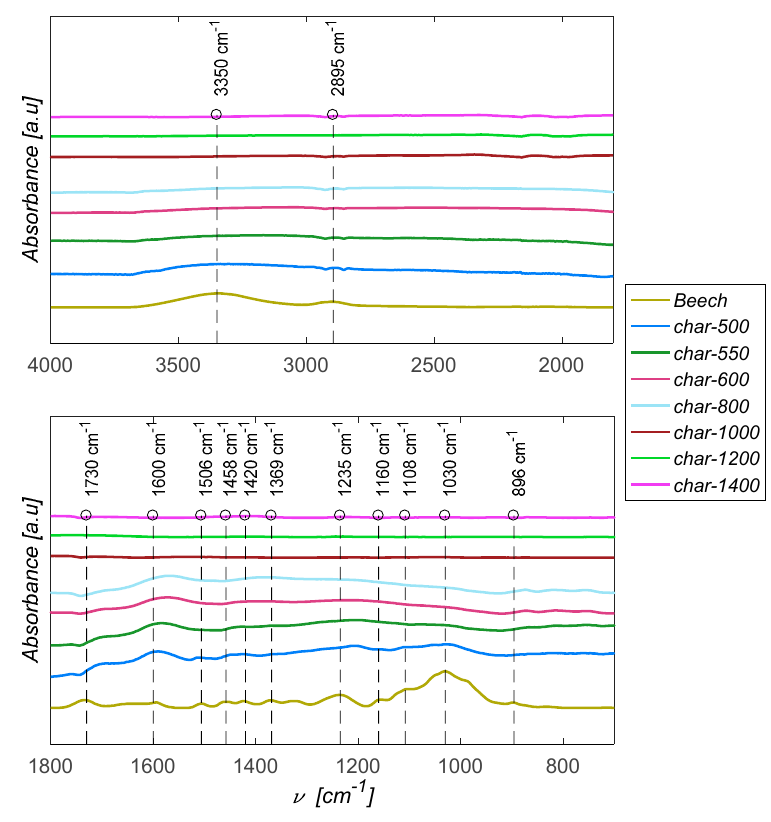
Figure 7. FTIR spectra of the pyrolysis solid residues.